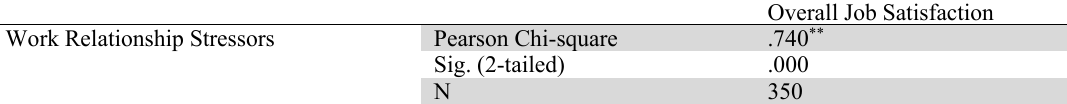
Chi-square tests for Work Relationship Stressors